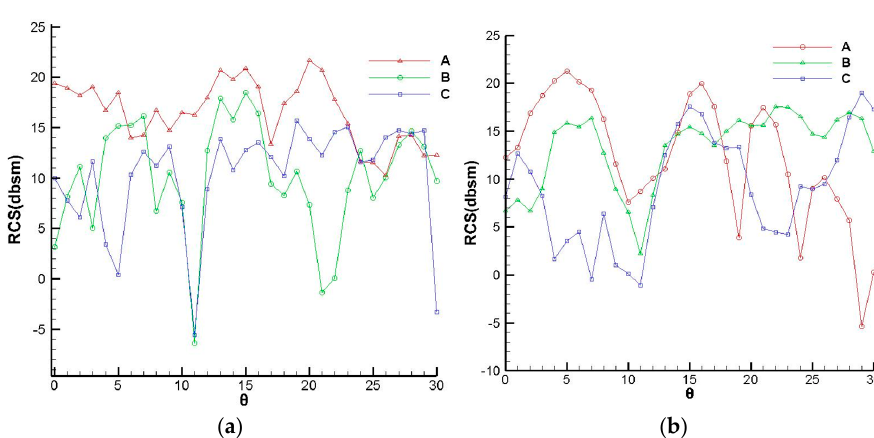
Figure 16. Distribution of flow field.